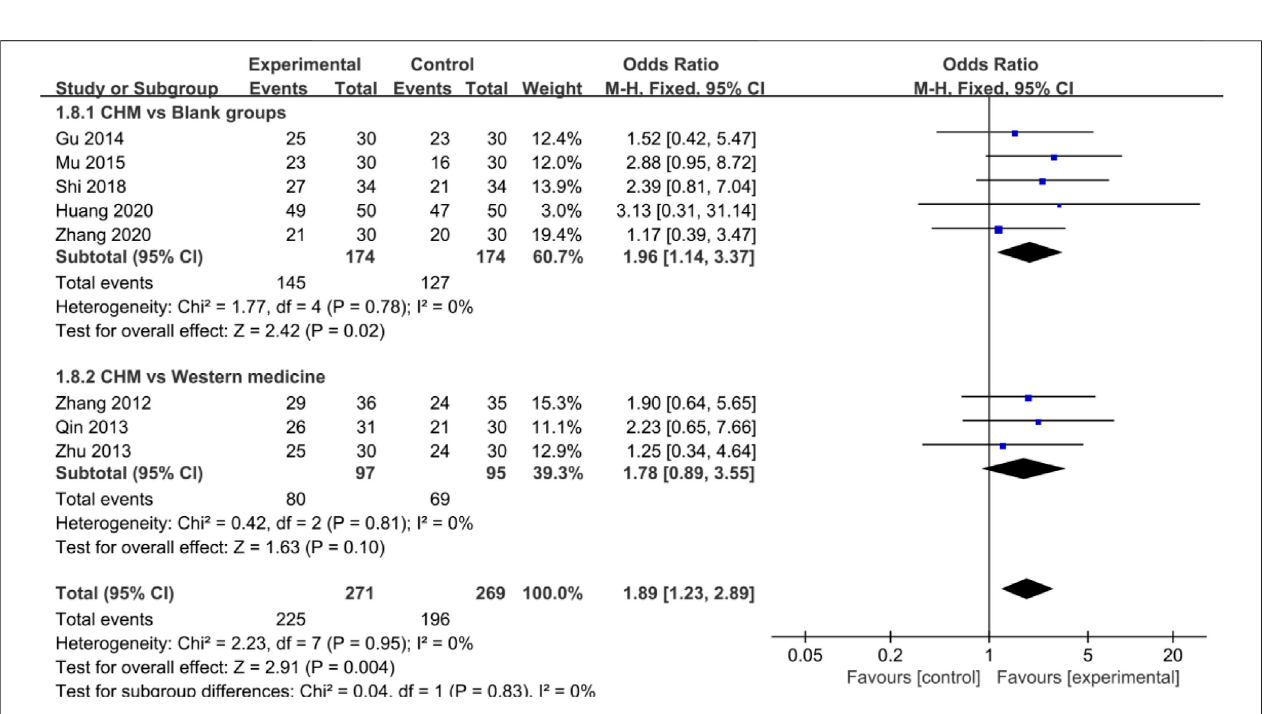
FIGURE 7 | Forest plot: CHM improved ECG in CHD with depression compared with control groups.